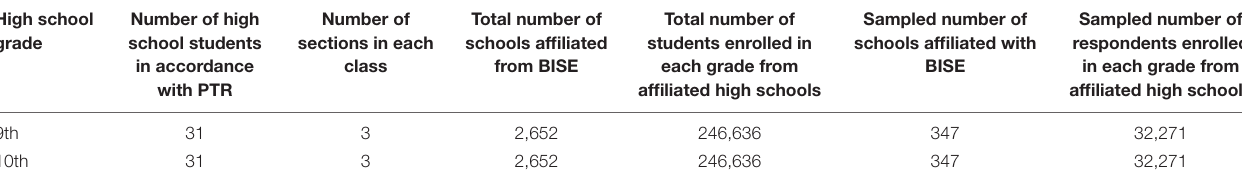
TABLE 2 | Total and sampled number of affiliated schools and students from grade 9th and 10th